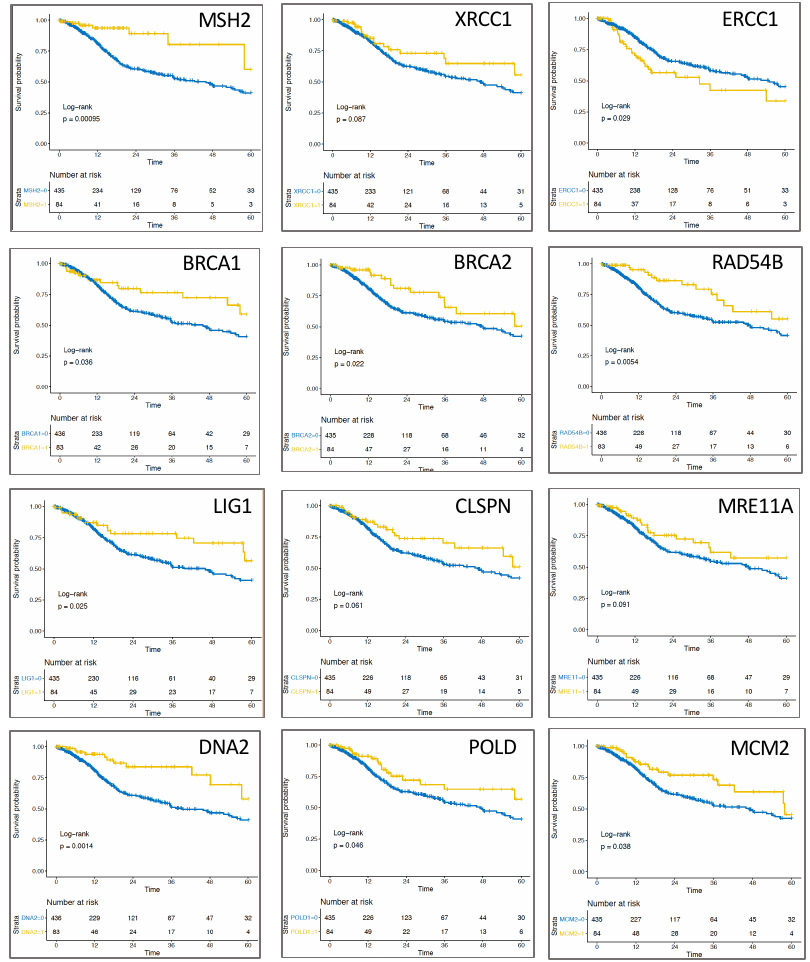
Figure 3. Survival probability is determined by mRNA expression of the DNA repair proteins MSH2, XRCC1, ERCC1, BRCA1, BRCA2, RAD54B, LIG1, CLSPN, MRE11A, DNA2, POLD1 and MCM2 in 519 HNSCC patients of the TCGA dataset using Kaplan-Meier survival curves up to 60 months after therapy. The 15% of patients with the lowest and/or highest protein expression were compared with the remaining patients. Differences between both groups were determined by the log-rank